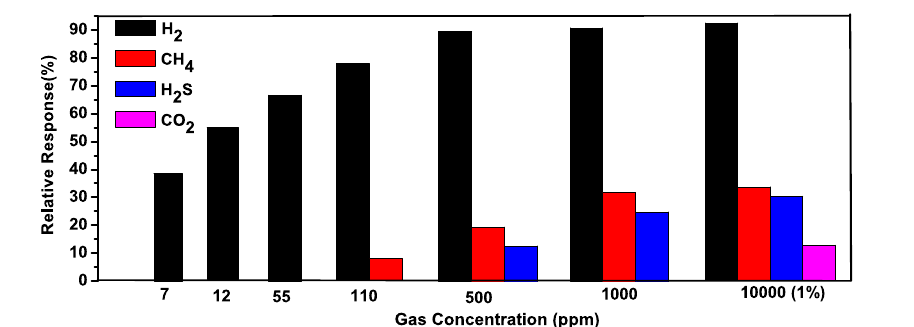
Figure 7. The selectivity histogram of the sensor to H 2 , CH 4 , H 2 S and CO 2 at 175 °C operating